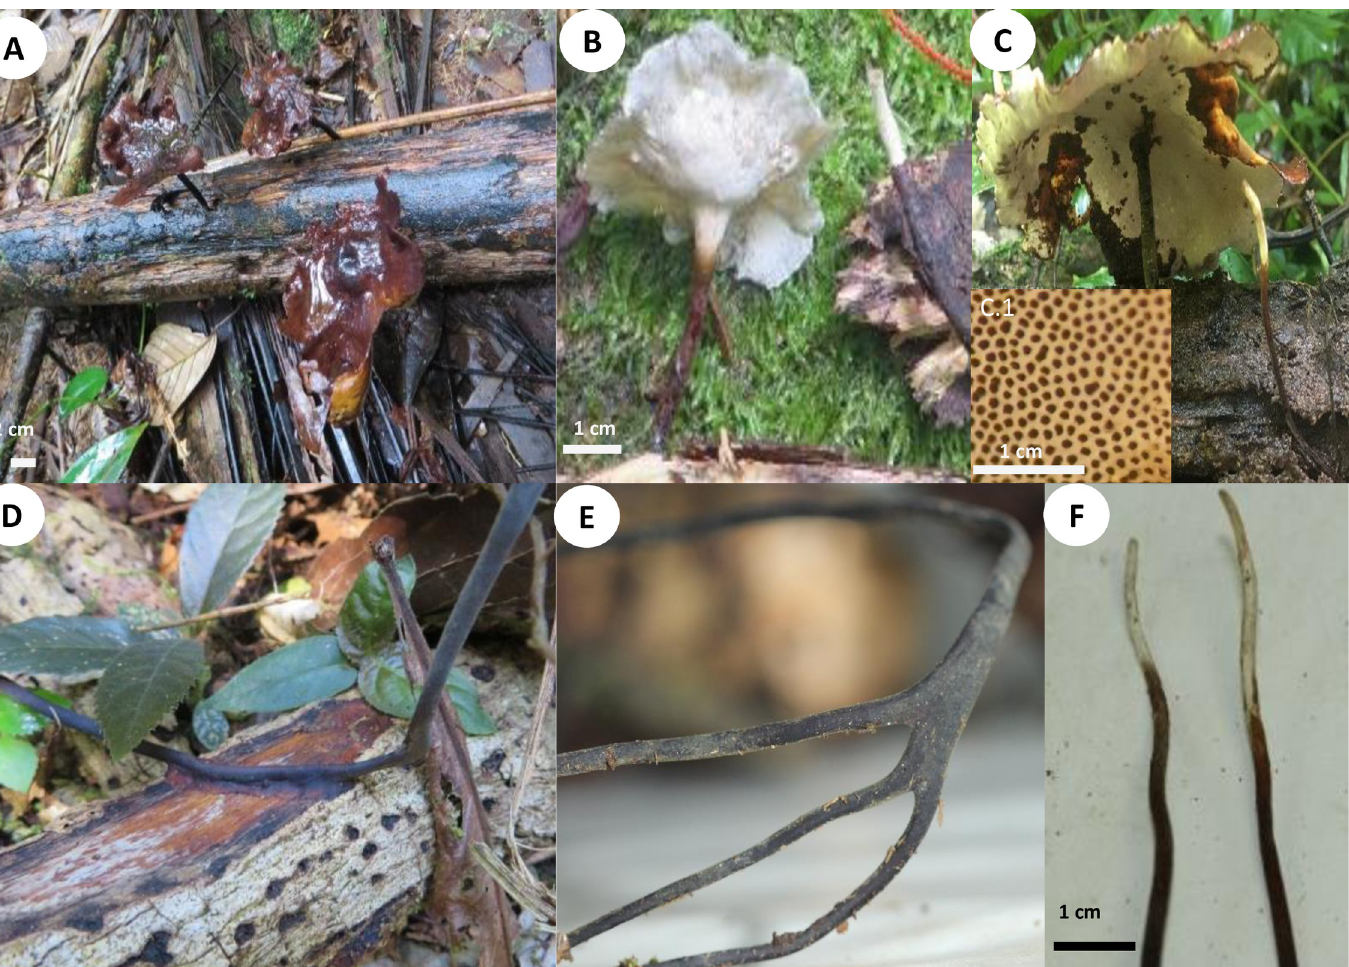
Fig 2. Basidiomata and rhizomorphs of Atroporus yasuniensis . A. gregarious habit of basidiomata. B. young basidiome. C. aged basidiome. C.1. pore layer. D. brown- reddish rhizomorphic mat on decayed wood formed posterior to rhizomorph attachment. E. Branching of rhizomorphs. F. fresh rhizomorphs with the active growing region